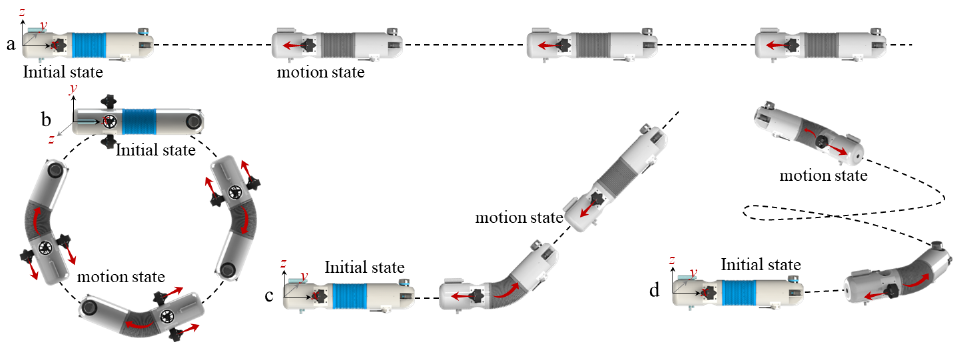
Figure 2. Schematic diagram of multi-modal motion of snake robot: ( a ) linear motion, ( b ) turning motion, ( c ) pitching motion, ( d ) helical motion.